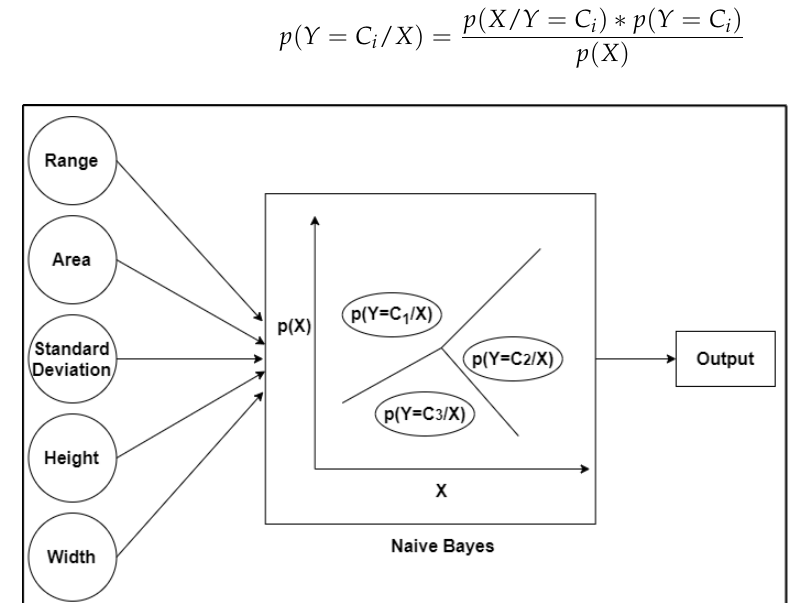
Figure 12. Naive Bayes Model.